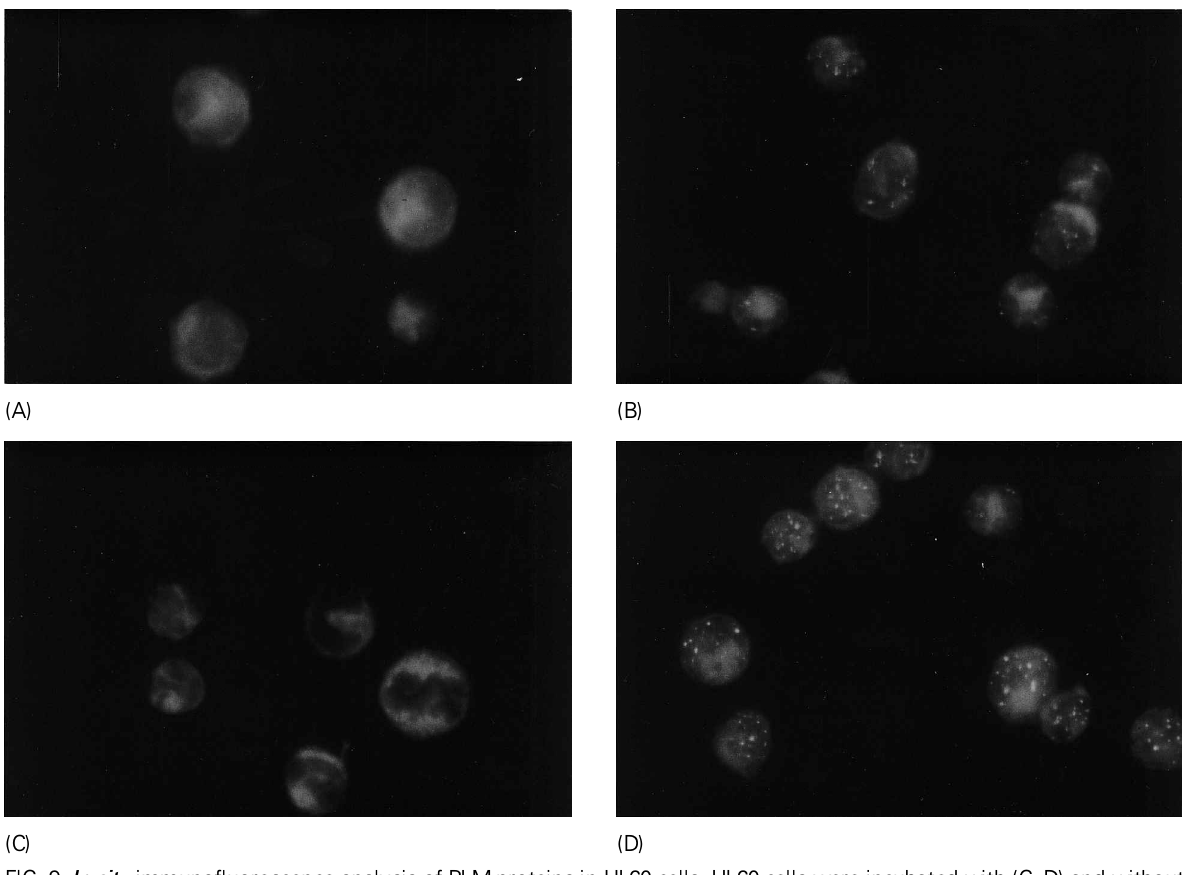
FIG. 9. In situ immunofluorescence analysis of PLM proteins in HL60 cells. HL60 cells were incubated with (C, D) and without (A, B) IFN- a (1000IU/ml) for 15h. Indirect immunofluorescence analysis was performed using the specific mouse monoclonal antibody PG-M3 (B, D) and normal mouse IgG (A, C) as control as described in Materials